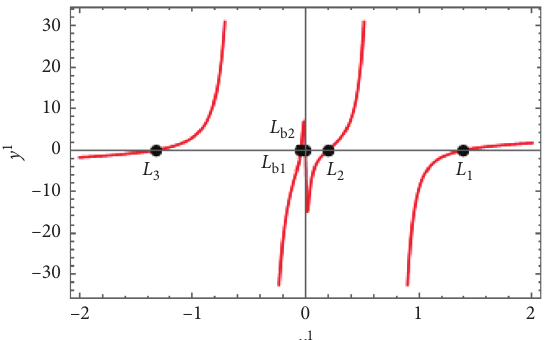
Figure 2: Locations of collinear equilibrium points.